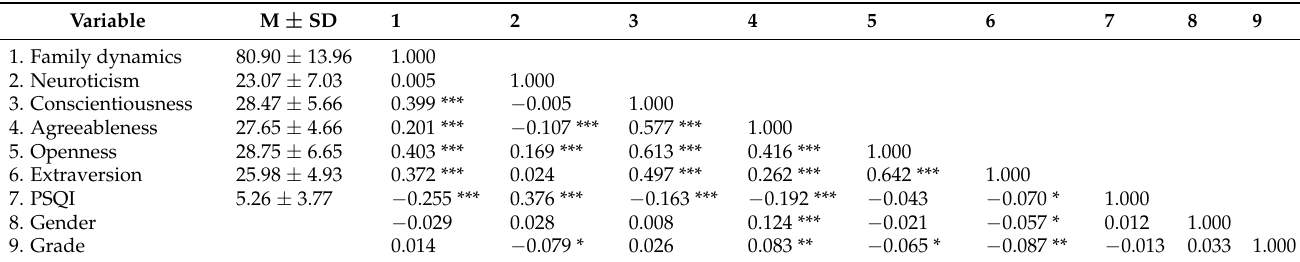
Table 2. Key variables and Spearman correlation coefficients of all variables.